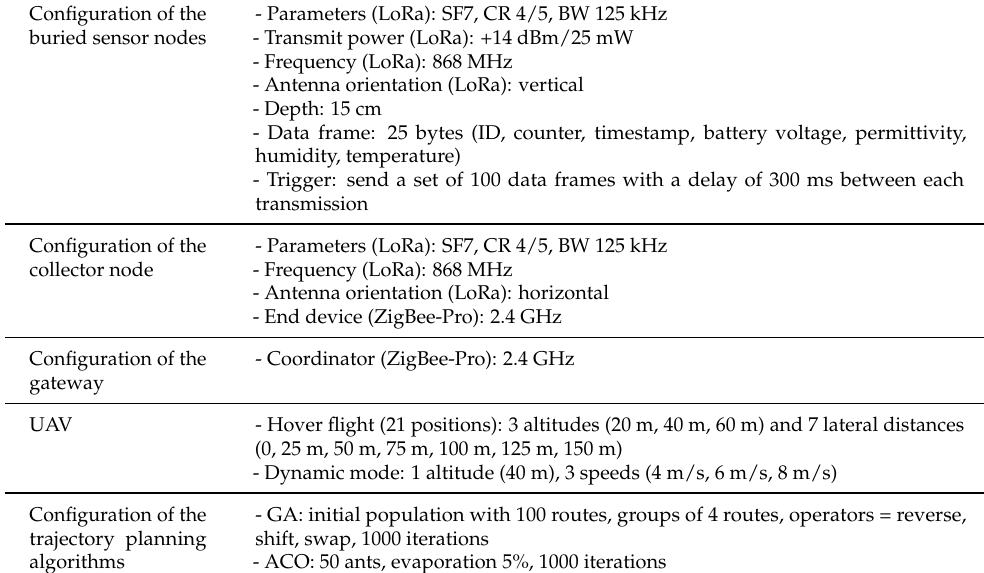
Table 4. Summary of the setup data. Configuration of the buried sensor